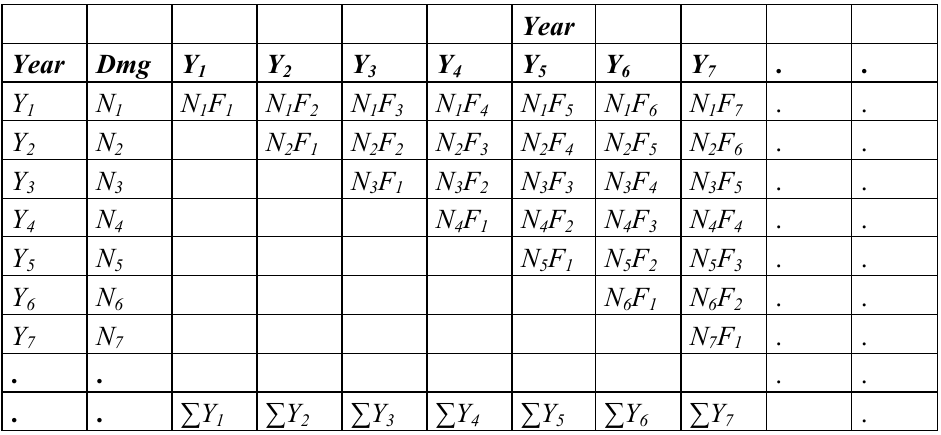
Table 1. The Life Matrix sums vertically the partial melanoma risks (N damages (N ) attained each year during a person’s life and gives the total melanoma risk i over life (bottom